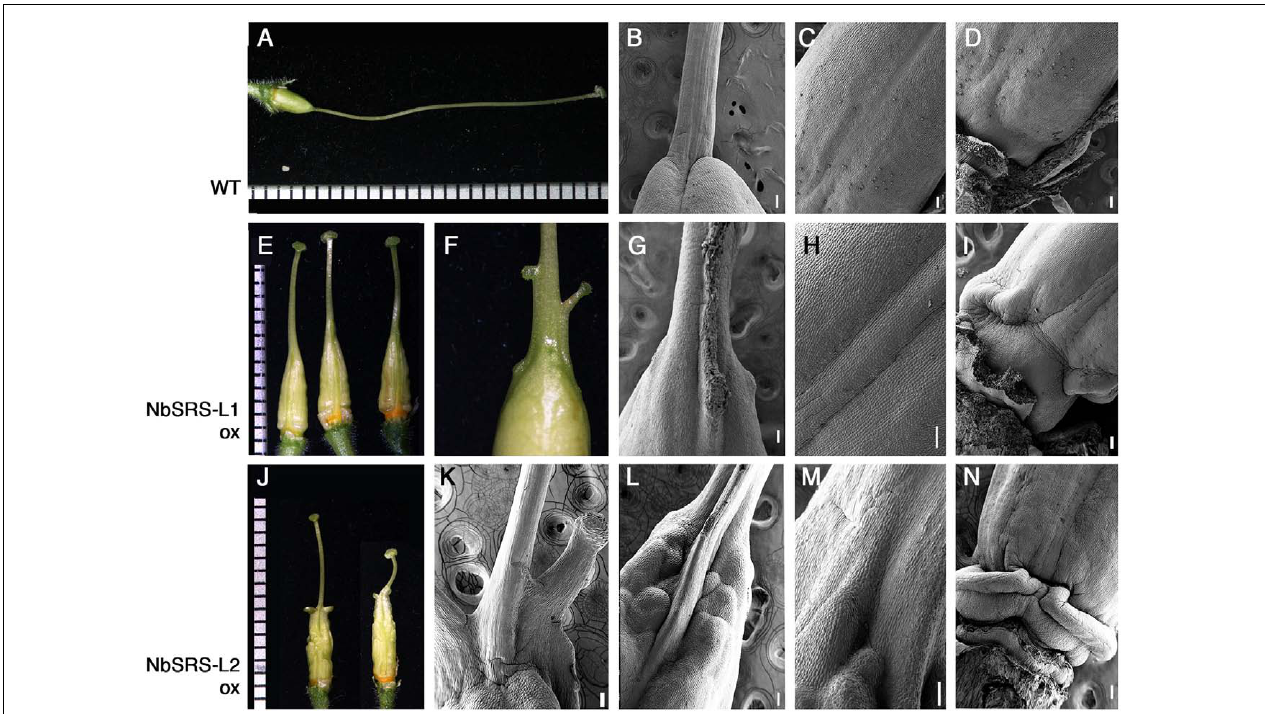
FIGURE 6 | Phenotypes of pistils of transgenic N. benthamiana lines overexpressing NbSRS-L1 or NbSRS-L2 genes. (A–D) Wild type pistils. (A) Lateral view. (B–D) Scanning Electron Micrographs of different parts of the wild type pistil. (B) Style-ovary junction. (C) Medial view of the ovary. The valve margins are adjacent and appear as a subtle crease at the center. (D) View of the gynophore at the basal end of the ovary. (E–I) 35S::NbSRS-L1 pistils. (E) Three pistils from different transgenic plants showing similar phenotypes. (F) Close-up of the ovary-style junction. Small protuberances capped with stigmatic tissue can be observed. (G–I) Scanning Electron Micrographs of 35S::NbSRS-L1 pistils. (G) Close-up of the ovary-style junction. Note the poor delimitation of both domains and the formation of ectopic stigmatic tissue. (H) Medial view of the ovary. The valve margins, which appear as constricted longitudinal ridges, leave a bulging area of several cell files between them resembling the Arabidopsis replum. (I) View of the elongated gynophore of a 35S::NbSRS-L1 pistil. (J–N) 35S::NbSRS-L2 pistils. (J) Two pistils from different transgenic plants showing similar phenotypes. (K–N) Scanning Electron Micrographs of 35S::NbSRS-L1 pistils. (K) Close-up of the ovary-style junction. Note the expansions of style tissue capped with stigmatic cells. (L) Close-up of the ovary-style junction of a different pistil. Note the bulging protrusion in medial position and the highly irregular ovary surface. The demarcation of style and ovary is not defined. (M) Close-up of another style-ovary junction where the mixed identity of style and ovary cells is observed. (N) View of the gynophore, where abnormal development of tissue is observed. Bars in micrographs: 100 µ